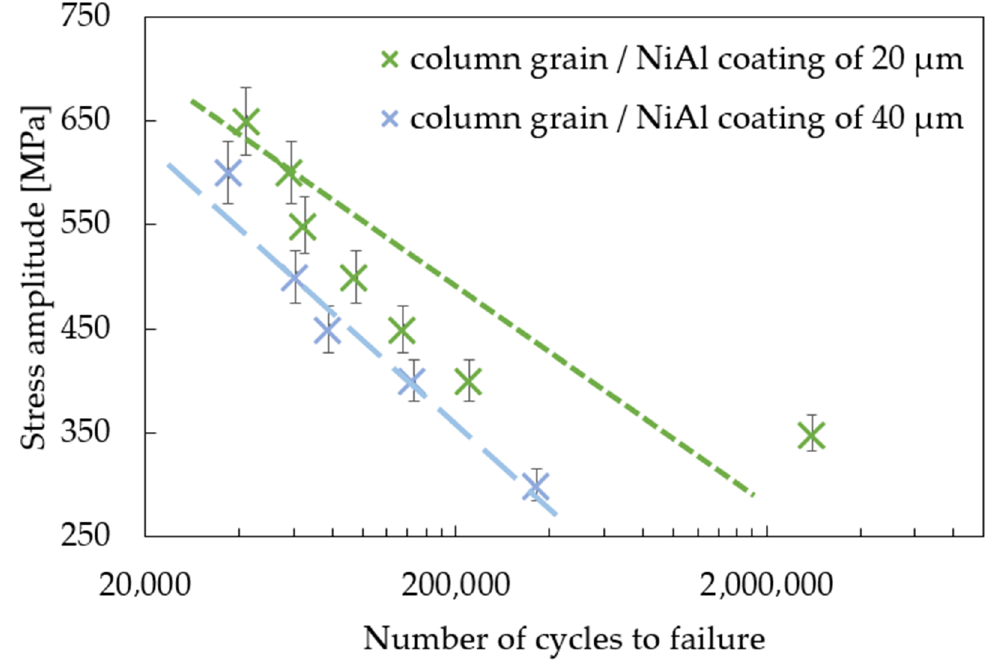
Figure 7. S-N curves for the coated, column-grained MAR 247 nickel-based superalloy.